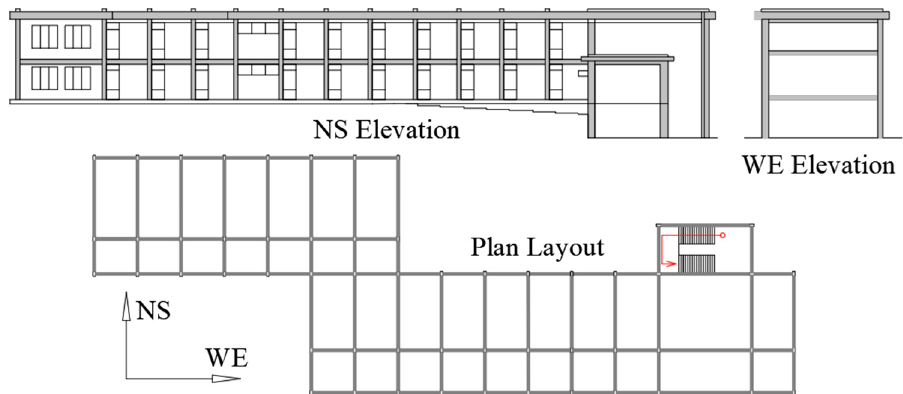
Figure 8. Plan and elevation layout of the case study building.